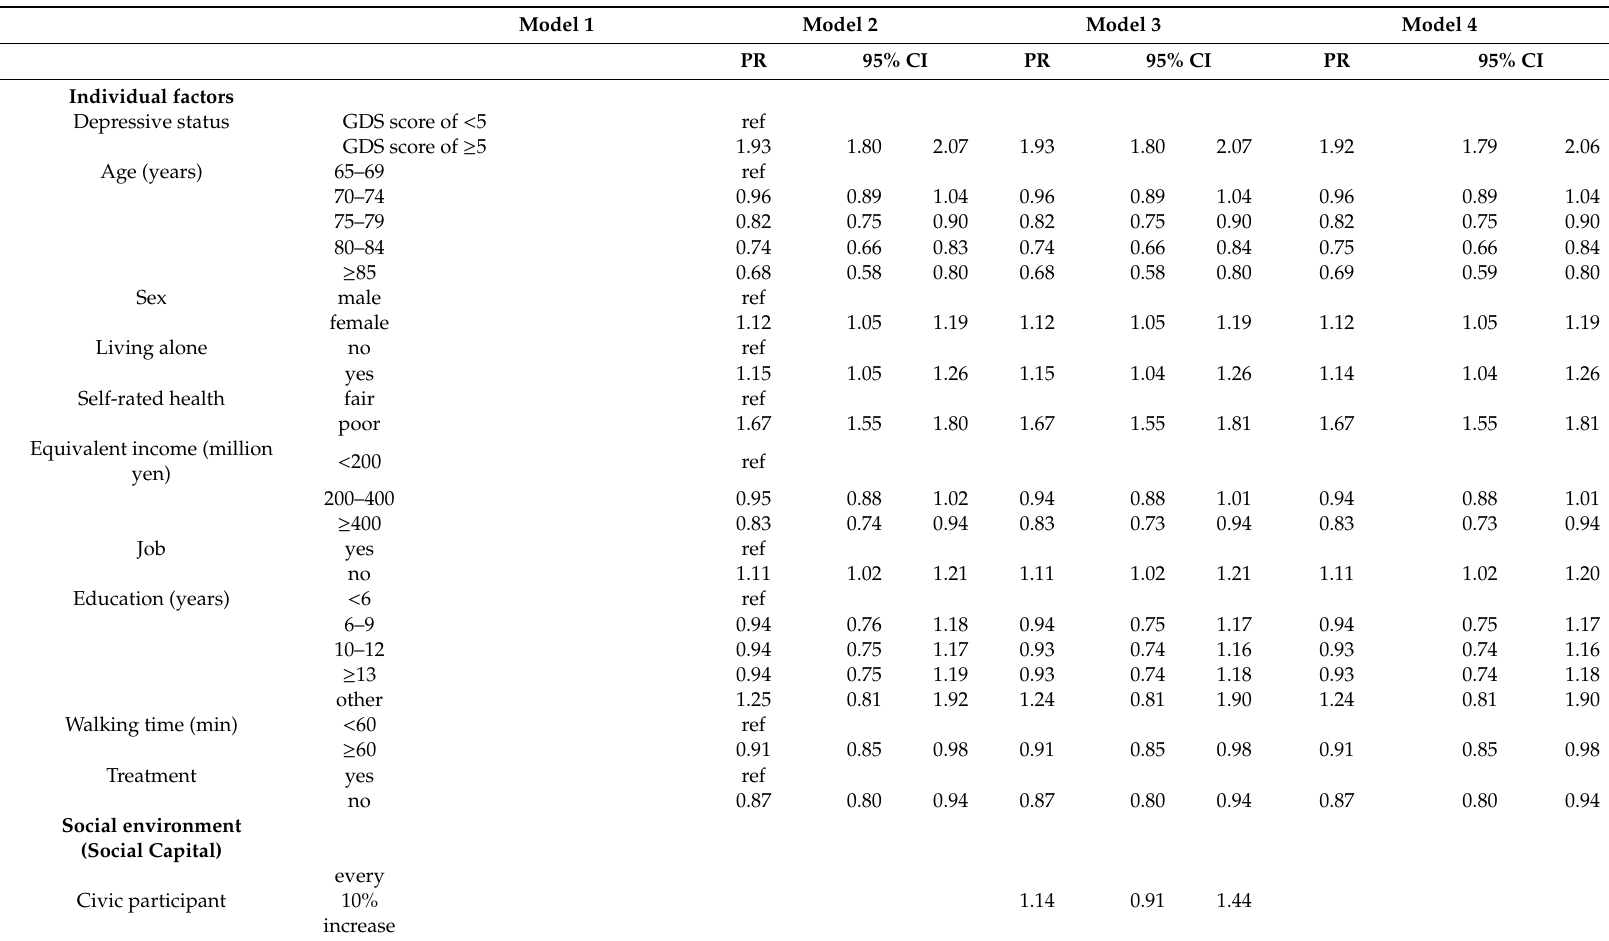
Table 3. Results of the multi-level Poisson regression analysis to study the association between neighborhood environment and sleep quality whole